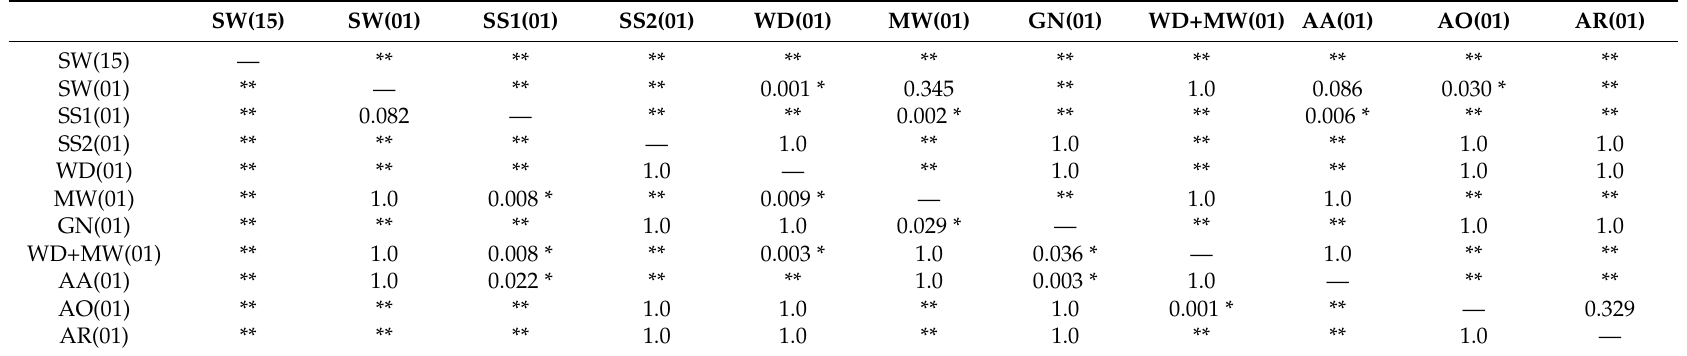
Table A13. Pairwise comparisons with Bonferonni correction for the putEMG dataset. The table shows the p -value of the comparison between the clustering metrics of the methods on the corresponding row and column. Values above the diagonal show the comparisons for the SC metrics and below the diagonal for the DB metrics (second and third columns of Table A9, respectively). An ‘*’ denotes a significant difference ( α = 0.05), while a ‘**’ denotes a p -value p <